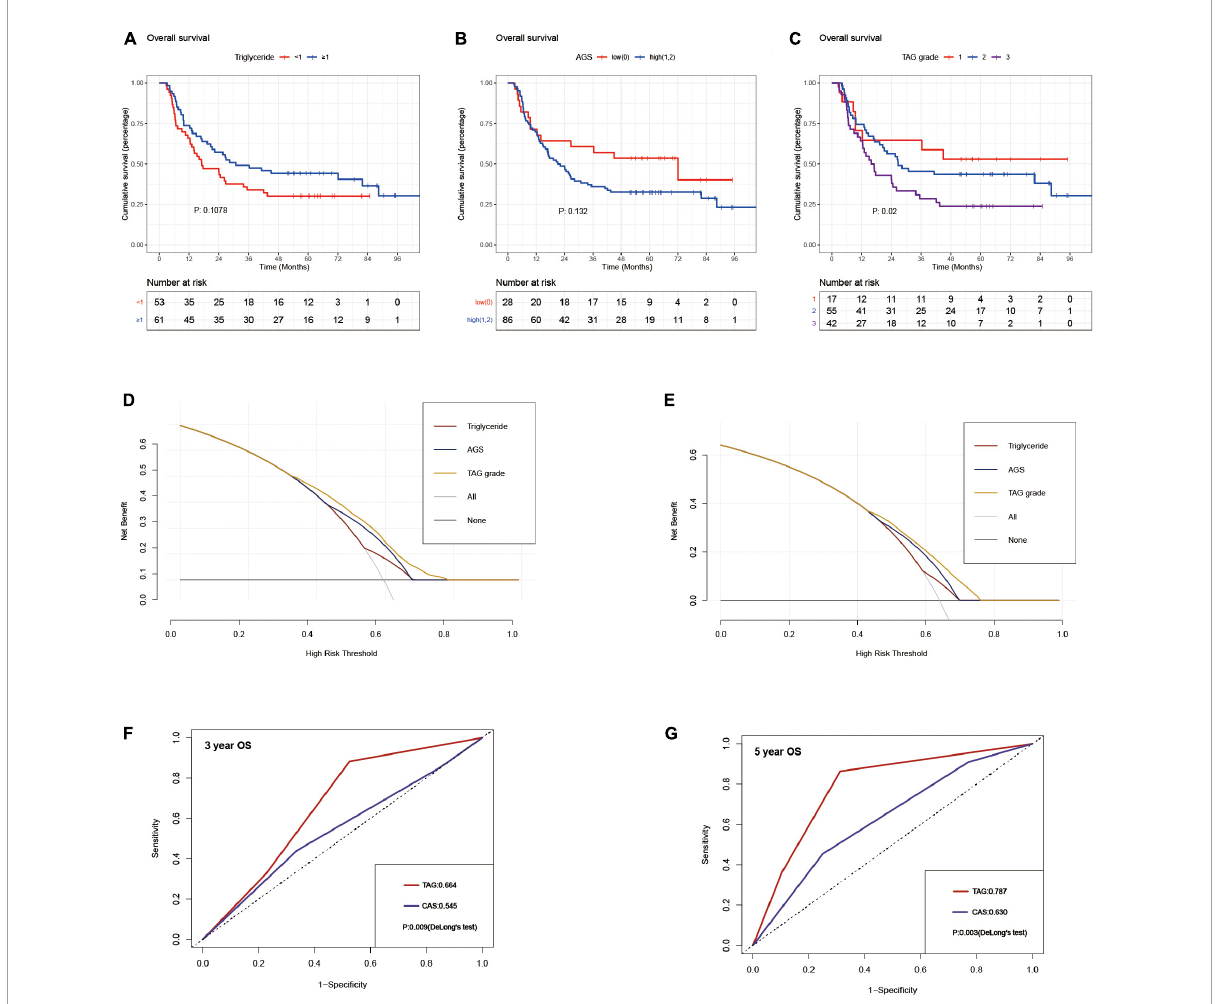
FIGURE2 Kaplan–Meier curves for overall survival stratified by triglyceride (A) , AGS (B) , and TAG grade (C) in the validation set; decision curve analyses for overall survival of triglyceride, AGS and TAG grade in the discovery set (D) and validation set (E) ; comparison of area under receiver operator characteristic curves for TAG and CAS grade in predicting 3-year (F) and 5-year (G) overall survival in the validation set using DeLong’s test; AGS, albumin-globulin score; TAG grade, triglyceride-albumin-globulin grade; CAS grade, combination of albumin-globulin score and skeletal muscle